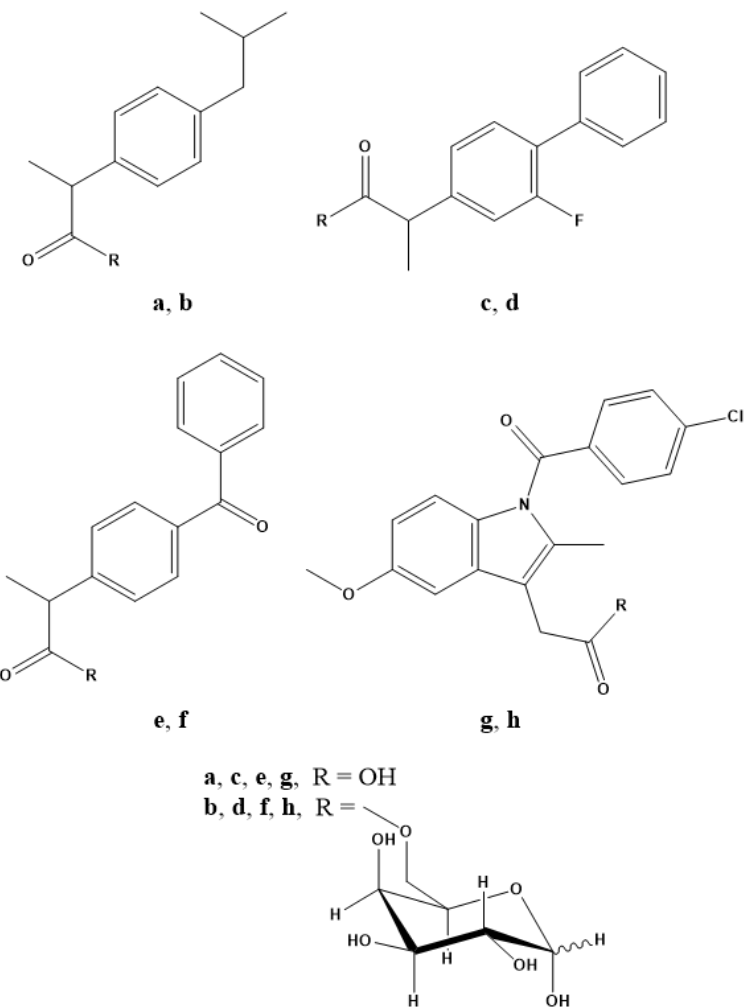
Figure 1. Chemical structures of ( a ) ibuprofen, ( b ) IbuGAL, ( c ) flurbiprofen, ( d ) FluGAL, ( e ) ketoprofen, ( f ) OkyGAL, ( g ) indomethacin and ( h ) IndoGAL.